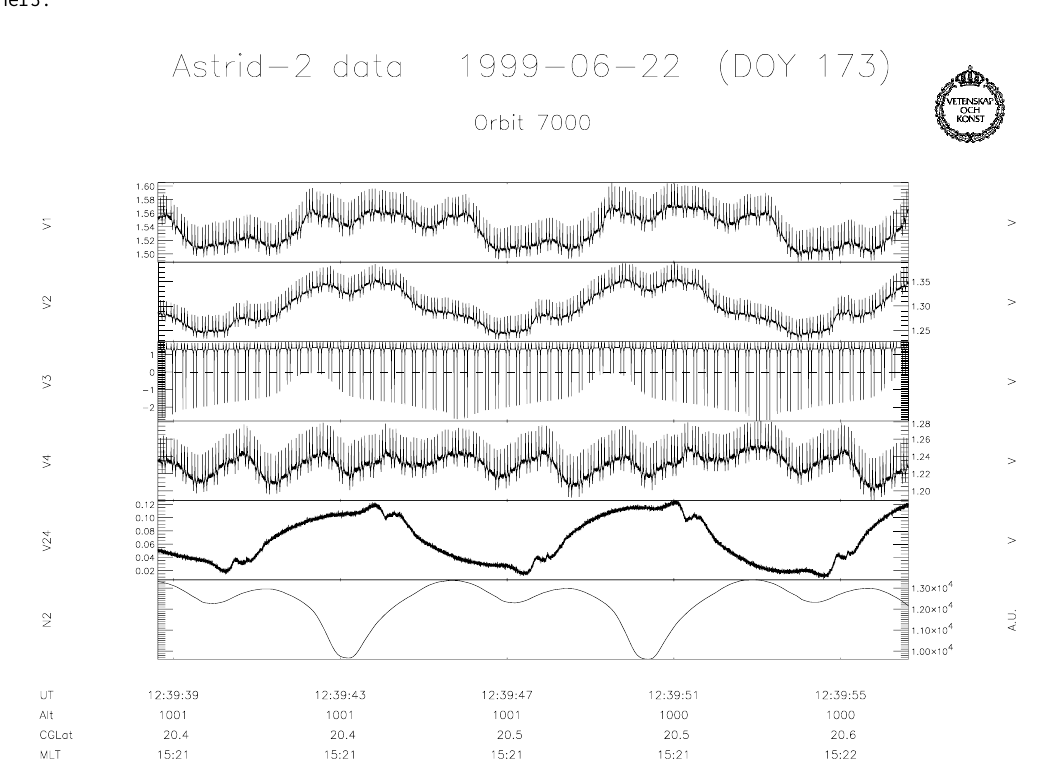
Fig. 6. Two spin periods of the interval in Fig. 5. The panels are the same as the top six panels of Fig.